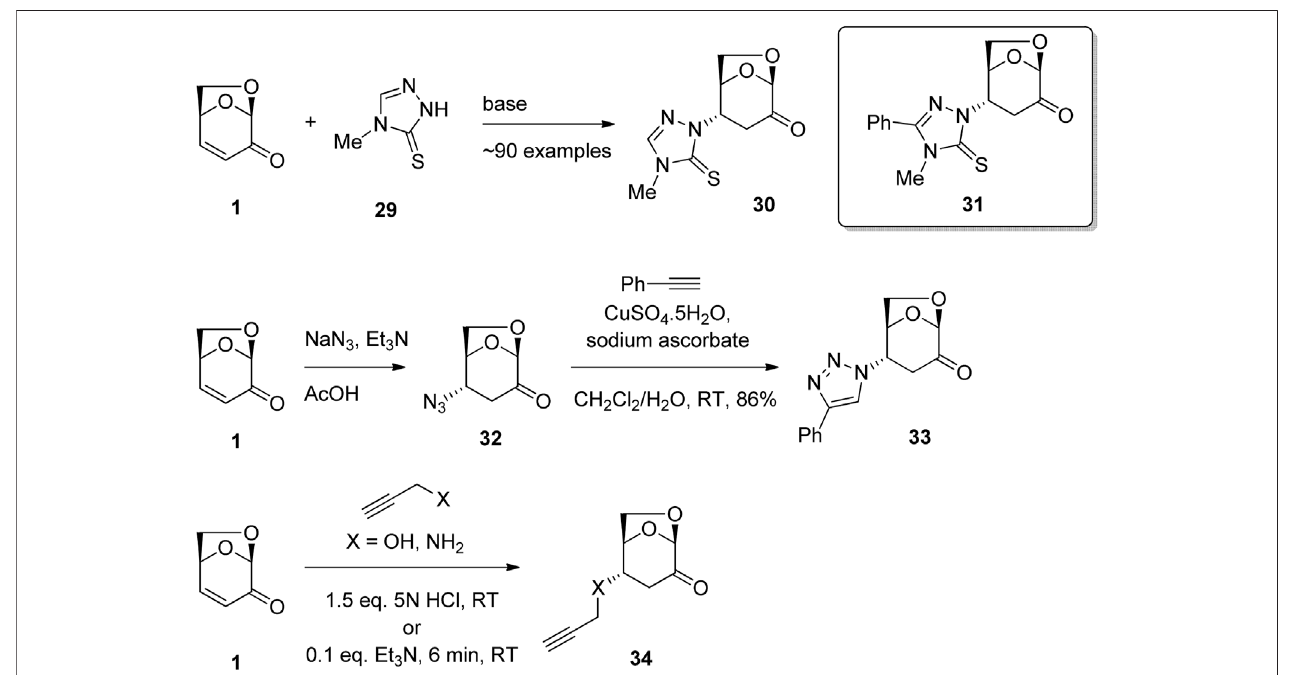
FIGURE 10 | Anticancer derivatives of LGO via aza-Michael addition reactions.